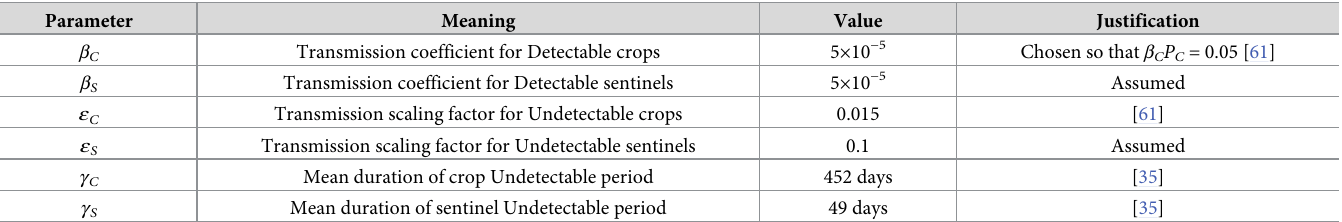
Table 1. The epidemiological parameters of the model, their meanings, and their baseline values chosen to be consistent with X . fastidiosa infection in O . europaea (crop) and C . roseus (sentinel). Other model parameter values are considered in S2 Text, S1–S2 Tables, and S2–S10